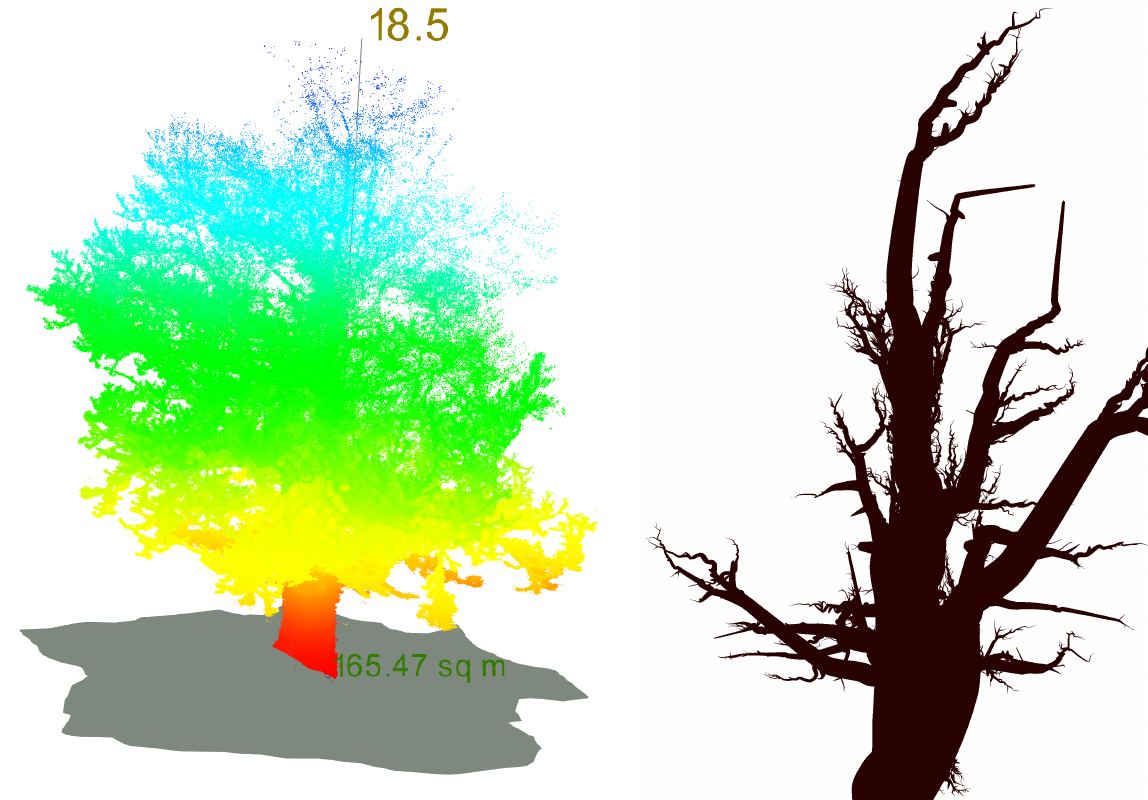
Figure 3. The veteran chestnut tree in the winter season. 3DForest outputs showing the TH (m) and the crown basal area (sq m). The color scale is in accordance with the z-axis gradient. Figure 4. Mesh of the tree skeleton by AdQSM